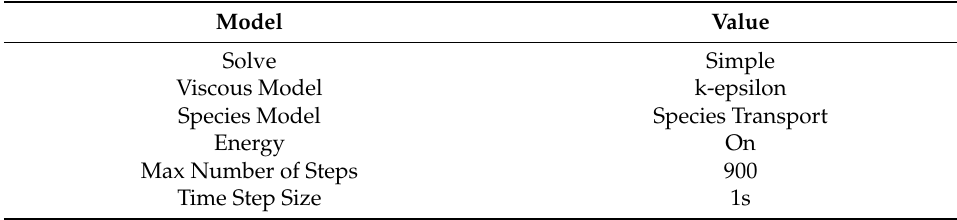
Table 7. Settings of model parameters for Tset 2.